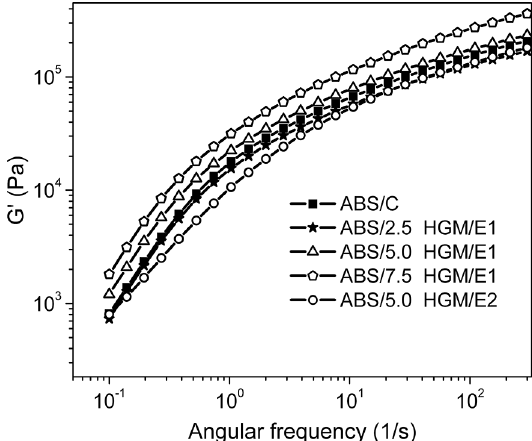
Figure 3. Storage modulus (G’) versus angular frequency for composites with 2.5, 5.0 and 7.5 wt.% of HGM and composite with high impact ABS.